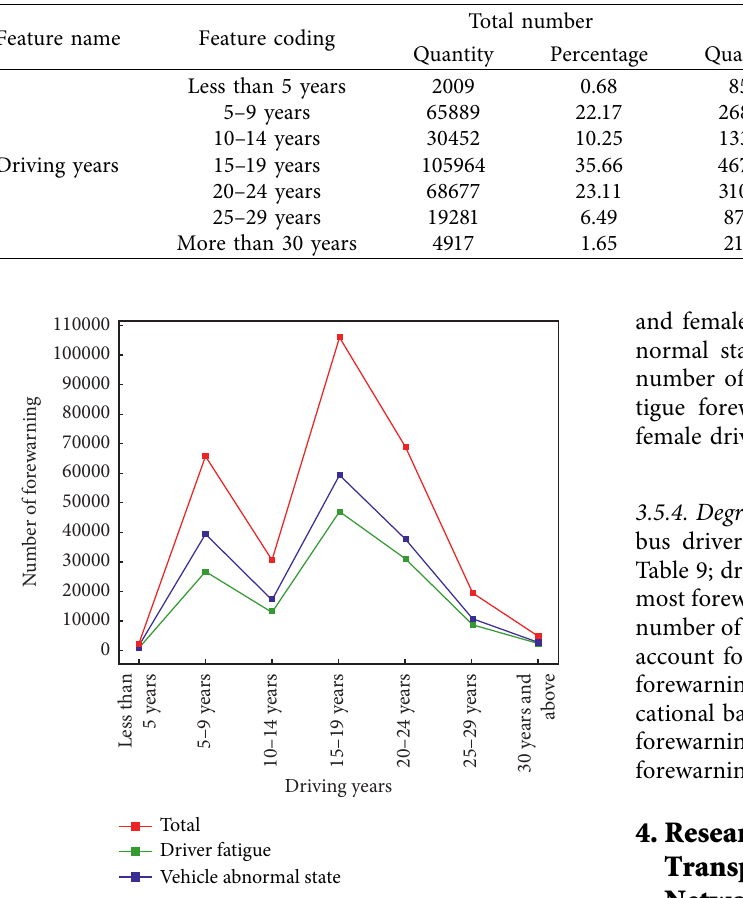
Figure 11: Distribution of forewarning types corresponding to drivers of different driving